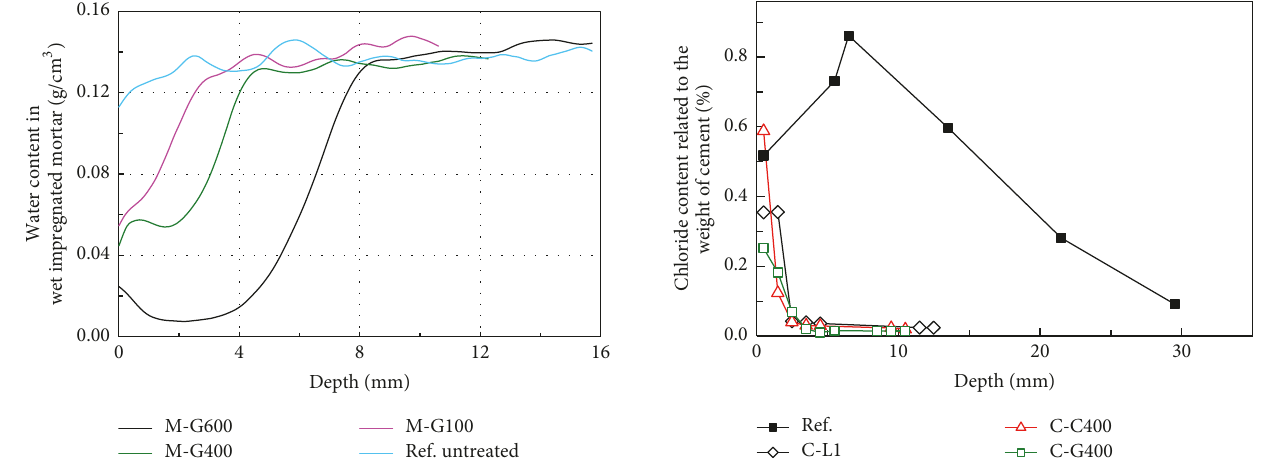
Figure 10: Chloride profiles of surface impregnated and untreated concrete after continuous contact with NaCl solution for 28